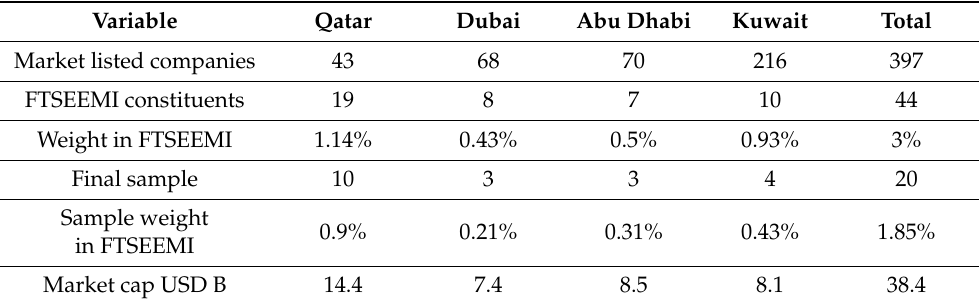
Table 1. Sample of